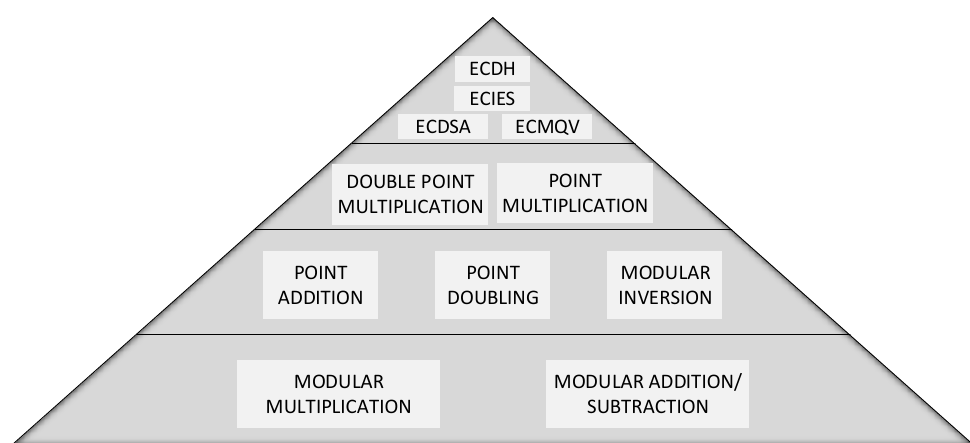
Figure 1. Implementation Hierarchy of the ECC